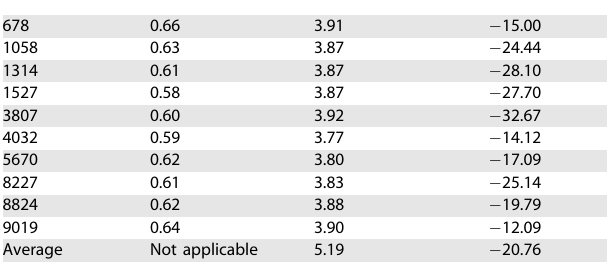
Model Number Foldhunter Score C a RMS Deviation Rosetta